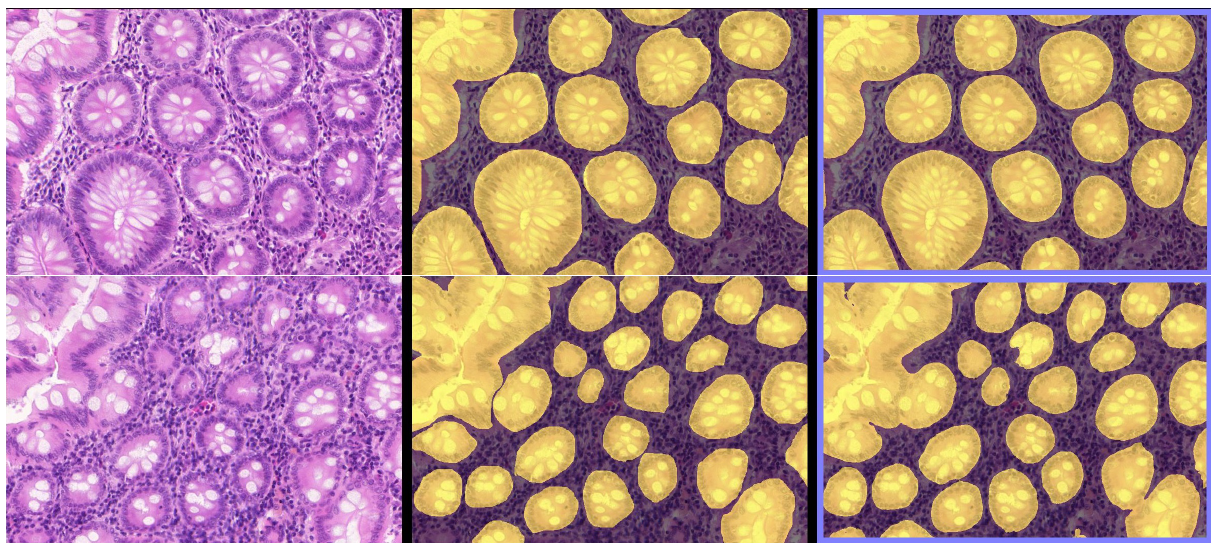
Figure 5. Sample image from PATH-DT-MSU dataset.